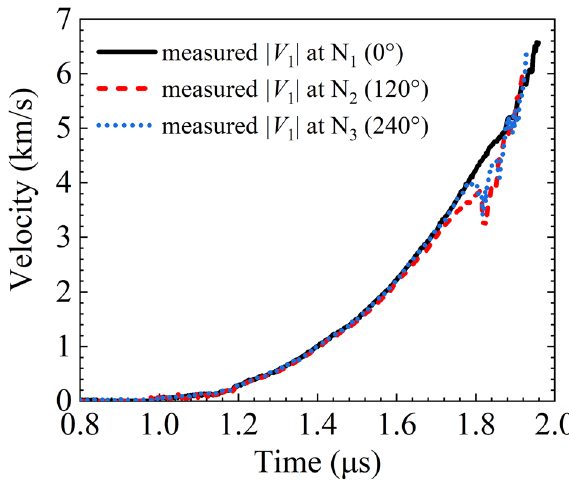
Figure 6. | V 1 | measured with the internal photonic Doppler velocimetry probes versus